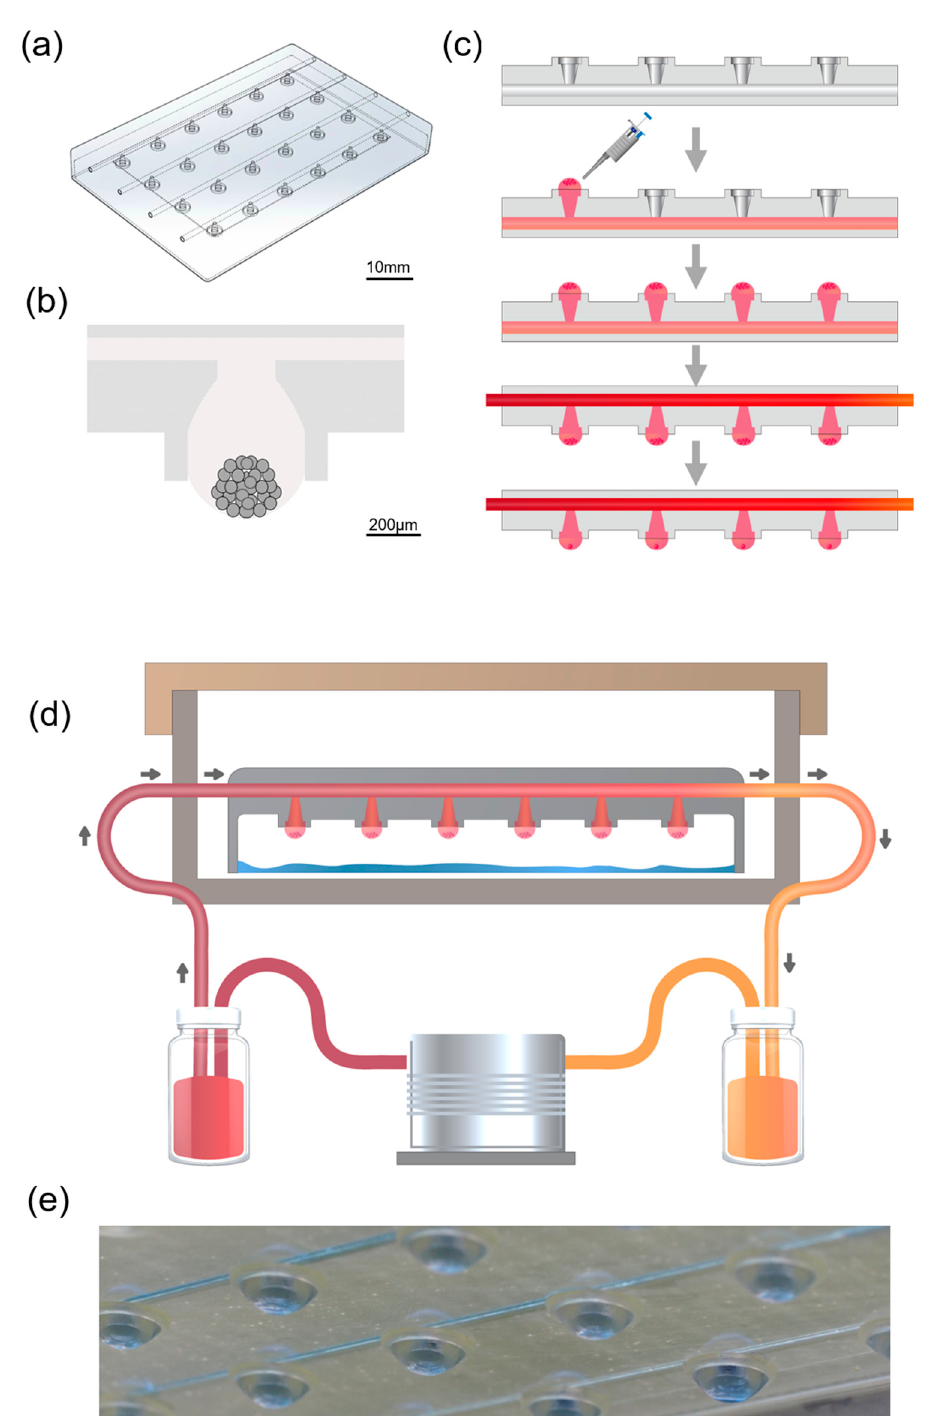
Figure 1. Schematic illustrations of the general concept and strategy for the microfluidic-based hanging-drop culture system. ( a ) Microfluidic-based hanging-drop culture chip. ( b ) Cell scattered at the bottom of the drop after seeding and aggregated into irregular shape spheroids cell in taper-tube. ( c ) The workflow of cell culture chip: fill the medium into the channel of the chip, add the cell into the tray, turn over the chip, then connect the chip with the culture system to start the culture of the spheroid. ( d ) Incubate the cells in the microfluid-based hanging-drop culture system for proliferation. ( e ) Photograph of the chip filled with water showing equal-size drops.